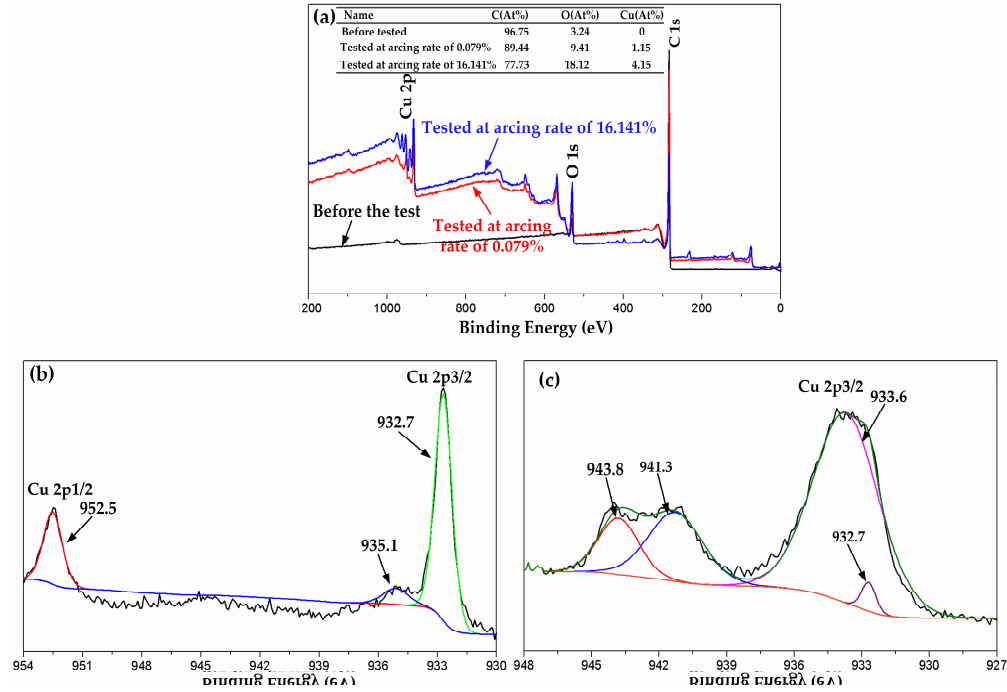
Figure 15. XPS test results: ( a ) XPS spectra of C 1s, O 1s and Cu 2p before and after the test at 120 A; ( b ) XPS spectra of Cu 2p at arcing rate of 0.079%; ( c ) XPS spectra of Cu 2p3/2 at arcing rate of 16.141%. Binding Energy was calibrated with C1s = 284.5 eV.